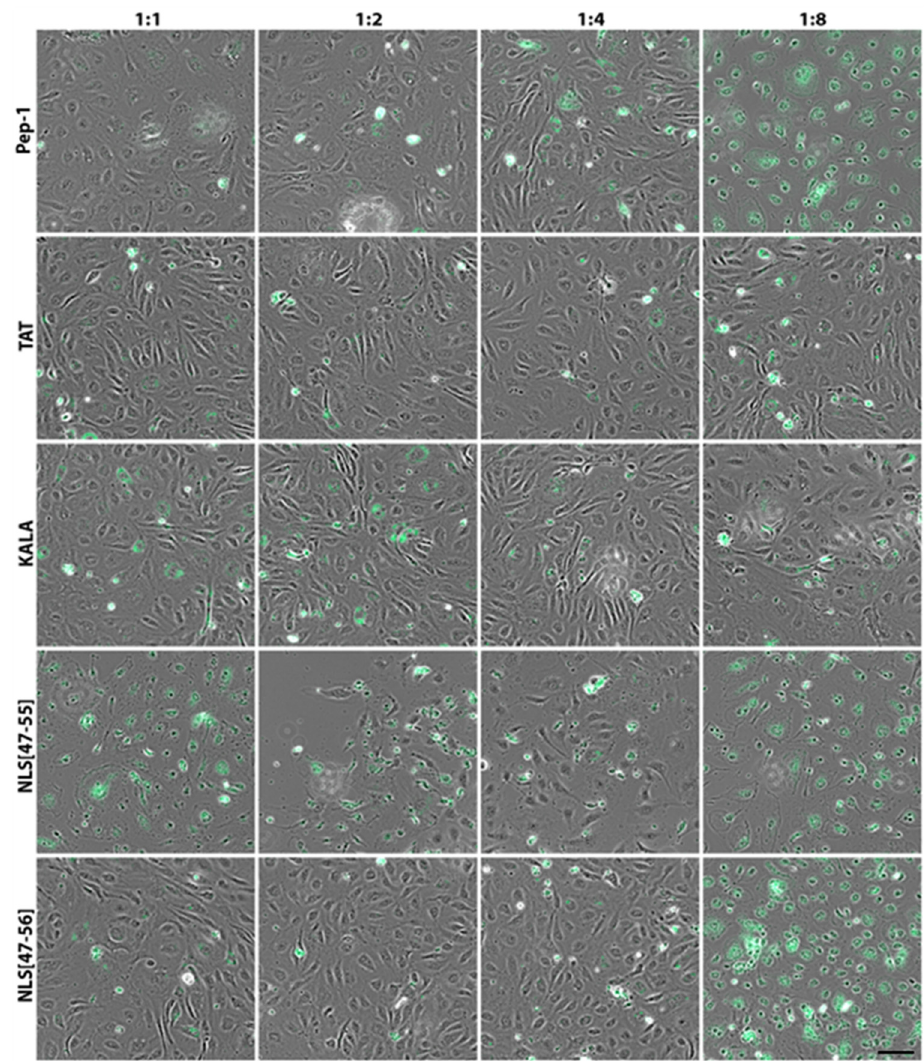
Figure 17. Effect of 48 h culture in the presence of complexes in CRs of 1:1, 1:2, 1:4 and 1:8. The complexes were formed using incubation of 2 μ g pmaxGFP with chosen CPPs at 37 °C for 15 min. CR, charge ratio. ( A ) Transfection efficiency. ( B ) Percent of cells with abnormal morphology. Data are presented as means, numbers in parentheses represent standard deviations.